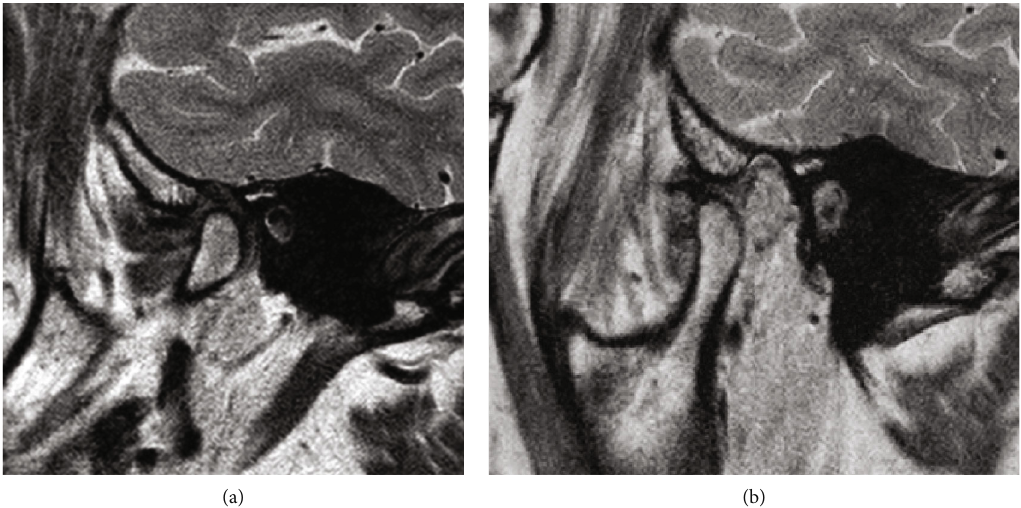
Figure 5: Dynamic MRI of the TMJ at 10-week follow-up with patient ’ s mouth closed (a) and open